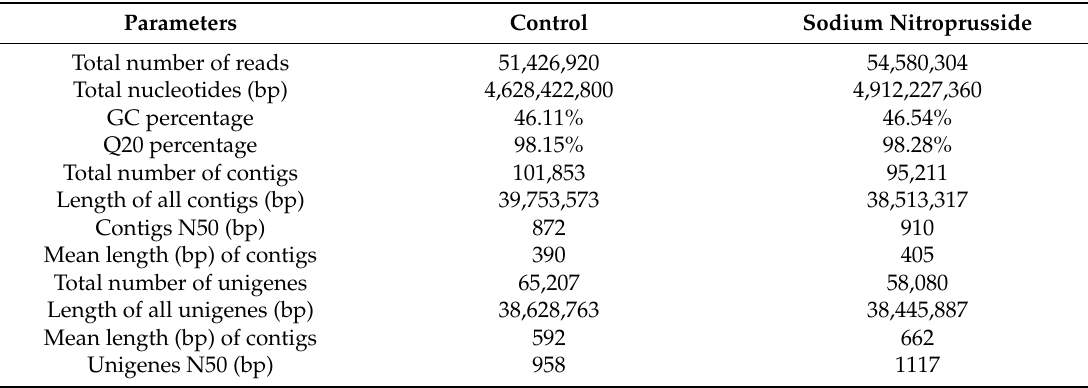
Table 2. Details of the sequencing and